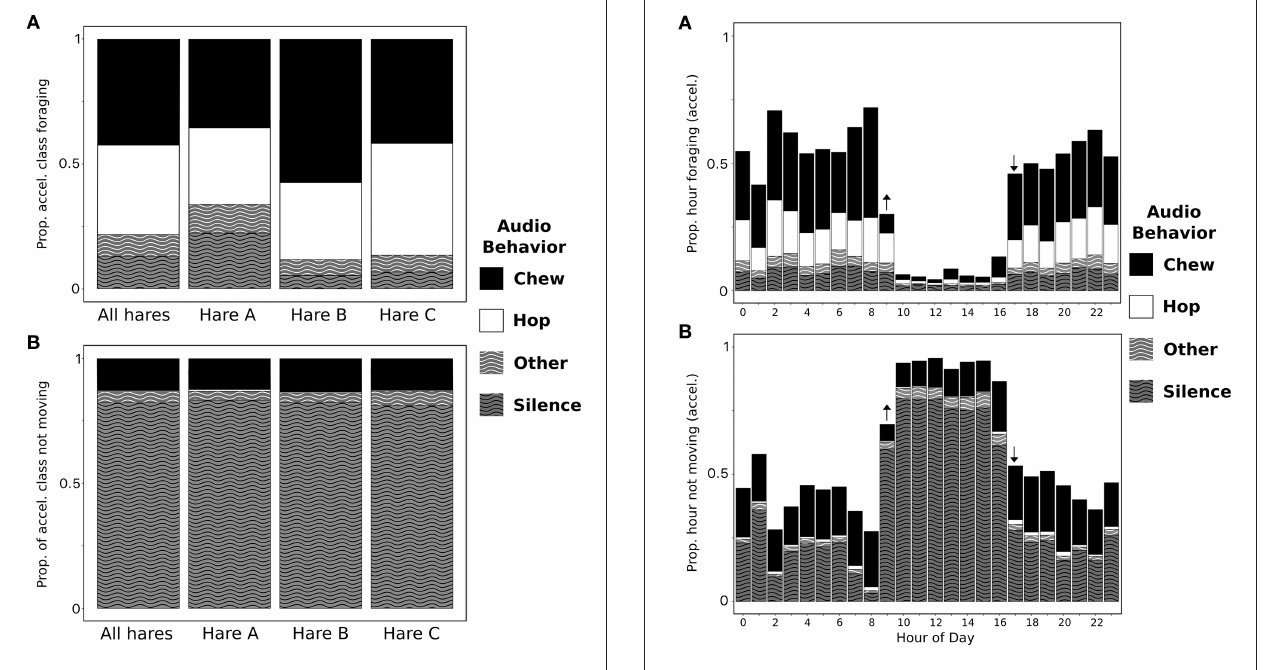
FIGURE 6 | Accelerometer classification of the proportion of each hour of the day spent foraging (A) and not moving (B) and the acoustic composition (chewing: black, hopping: white, silence: black stripe, or other: white stripe) of those behavioral states. All data was collected over the same 2 days from free-ranging snowshoe hares ( n = 3) that were outfitted with an accelerometer and an acoustic recorder. Arrows denote sunrise and sunset